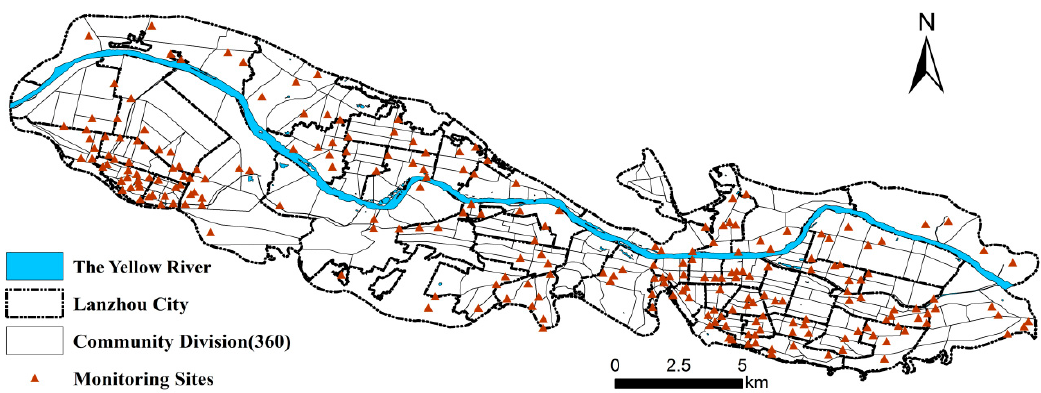
Figure 1. Overview of the study area.